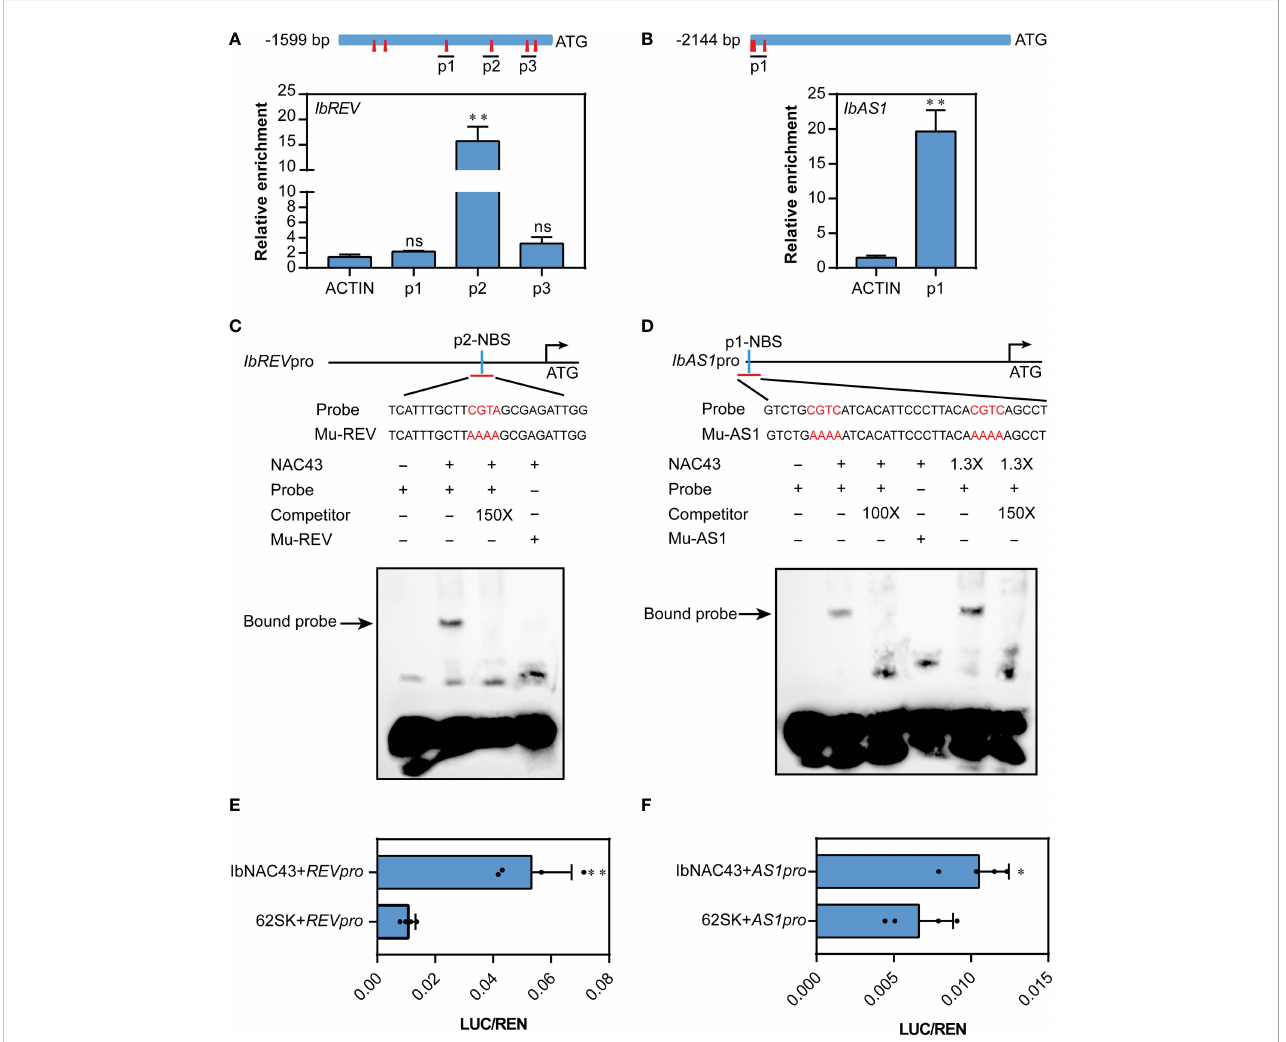
FIGURE 8 IbNAC43 directly binds to the promoters of IbREV and IbAS1 . (A, B) Locations of chromatin immunoprecipitation (ChIP) – quantitative PCR (qPCR) fragments and qPCR analysis of three biological replicates for the binding enrichment of IbNAC43 in IbREV and IbAS1 promoter regions. The PCR primers listed in Supplementary Table S1 were designed to amplify the IbREV and IbAS1 promoter regions. The NAC binding sequences (NBS) are represented by red prisms . (C, D) Electrophoretic mobility shift assays (EMSAs) demonstrate the interactions between IbNAC43 and the DNA motifs. The recombinant protein 6×His-IbNAC43 retarded the shift of the probe. Both 100× and 150× unlabeled probes were used as competitors. The plus sign and minus sign indicate presence and absence, respectively. NBS , NAC binding sequences containing CGTG/A/C; Mu-REV , CGTA was mutated as AAAA; Mu- AS1 , CGTG was mutated as AAAA. (E, F) IbNAC43 triggered the activity of IbREVpro -LUC and IbAS1pro -LUC, as determined by the dual-luciferase assays in rice protoplasts. The expression level of Renilla (REN) was used as an internal control. Data are values from four independent experiments and are presented as the mean ± SE ( n = 4). Asterisks indicate signi fi cant differences according to a Student ’ s t -test. * p < 0.05, ** p < 0.01. ns, not signi fi